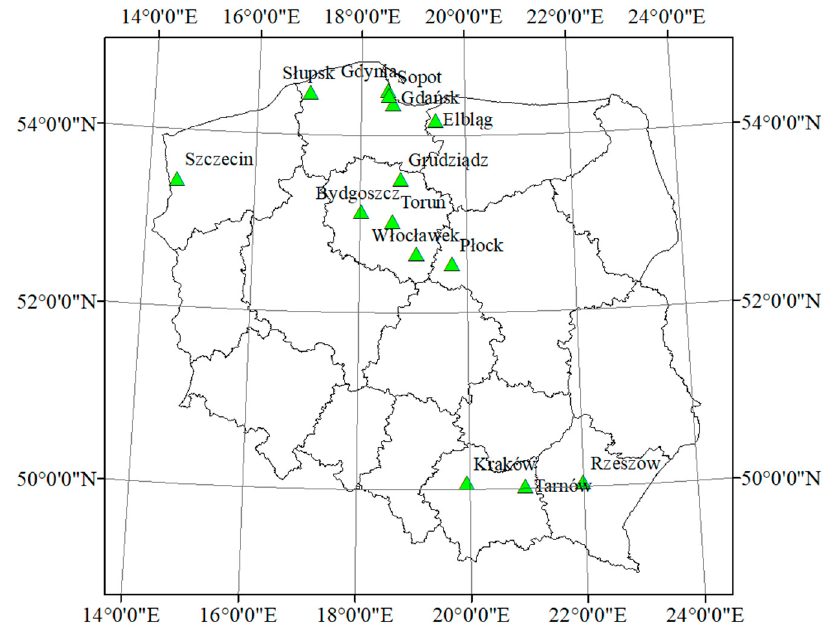
Figure 1. The location of the cities considered in the research.